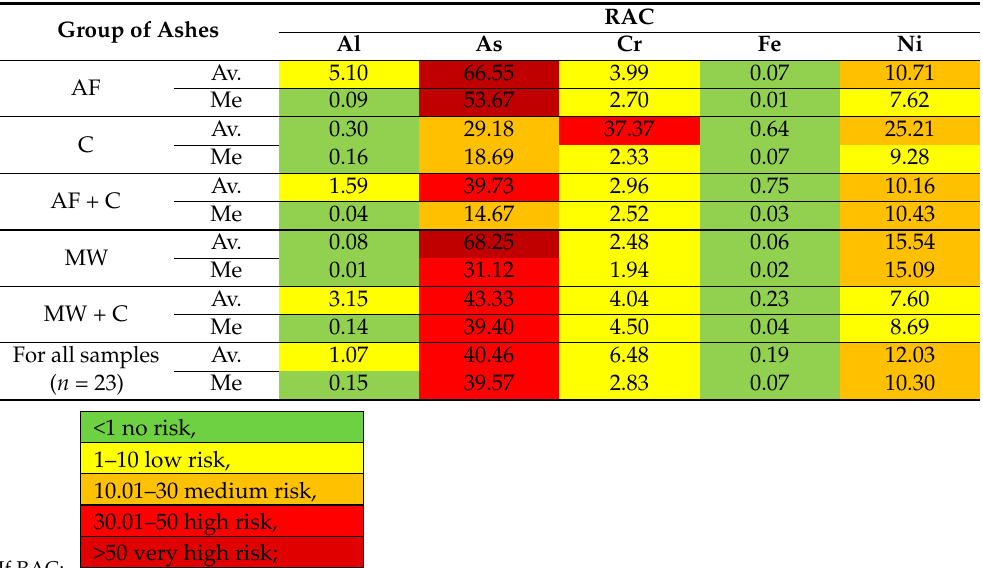
For all samples